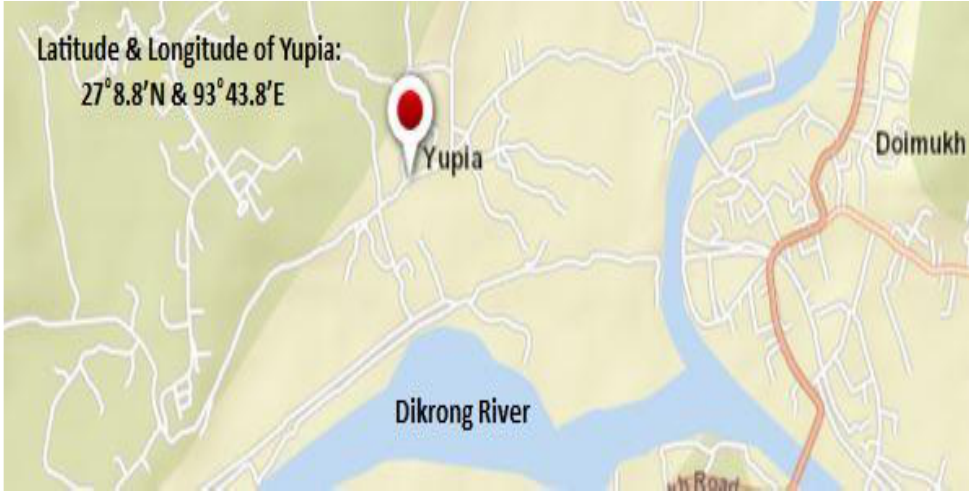
Figure 2. Map for the remote hilly town of Yupia.